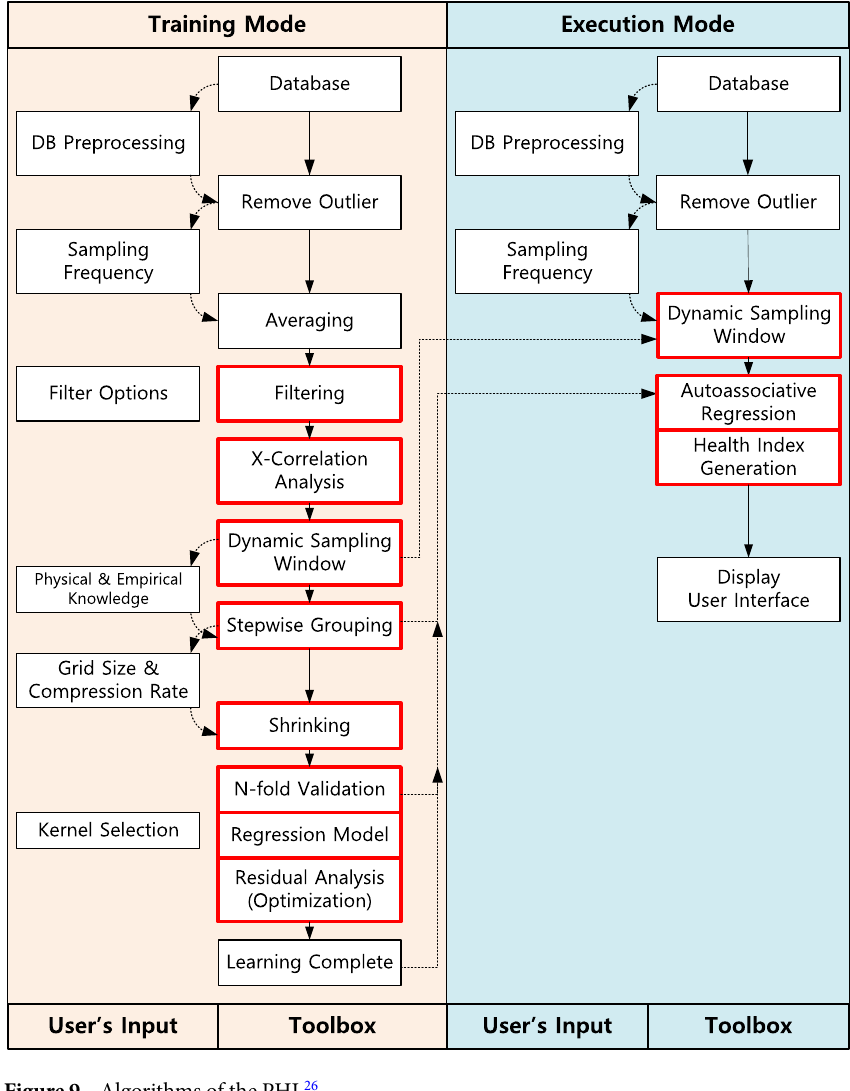
Figure 9. Algorithms of the PHI 26